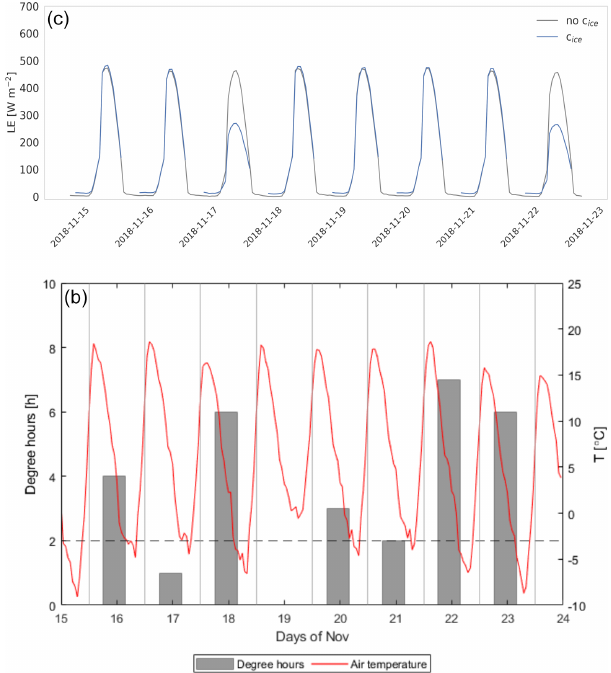
Figure A4. (a) The effect of the ice coefficient on the site-adapted Penman evaporation estimates. (b) Degree hours and air tempera- ture time